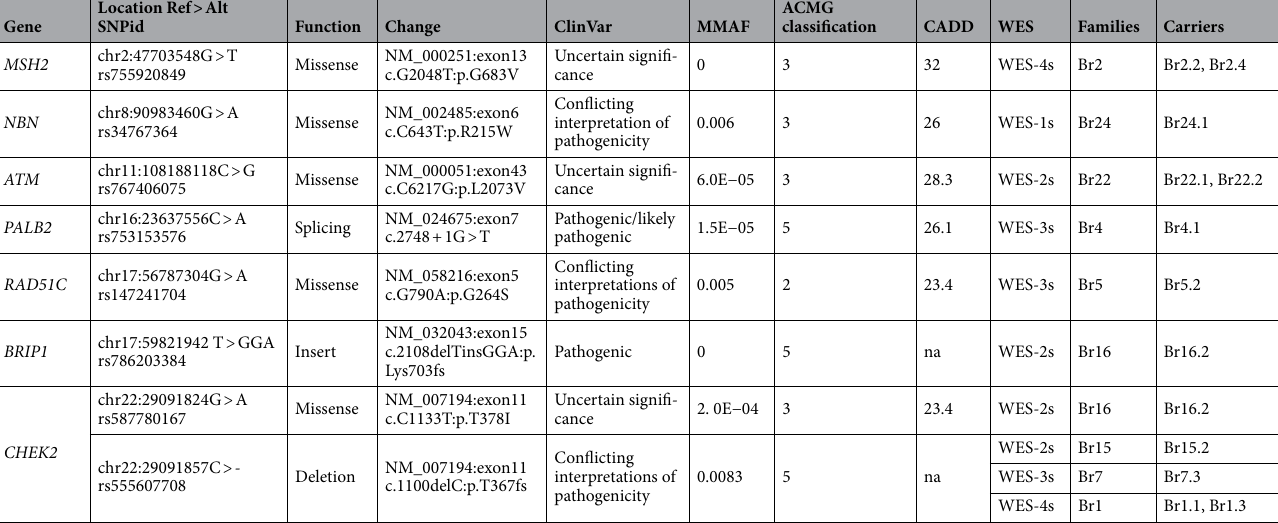
Table 1. Variants in known BC and OC predisposing genes. Location according to hg19, SNPid according to dbSNP150, Change shows transcript, exon, amino acid change and protein change. MMAF: Max ref AF indicates the highest reference allele frequency (see methods). WES-4s: families with 4 sequenced individuals; WES-3s: families with 3 sequenced individuals; WES-2s: families with 2 sequenced individuals; WES-1s: families with 1 sequenced individual.